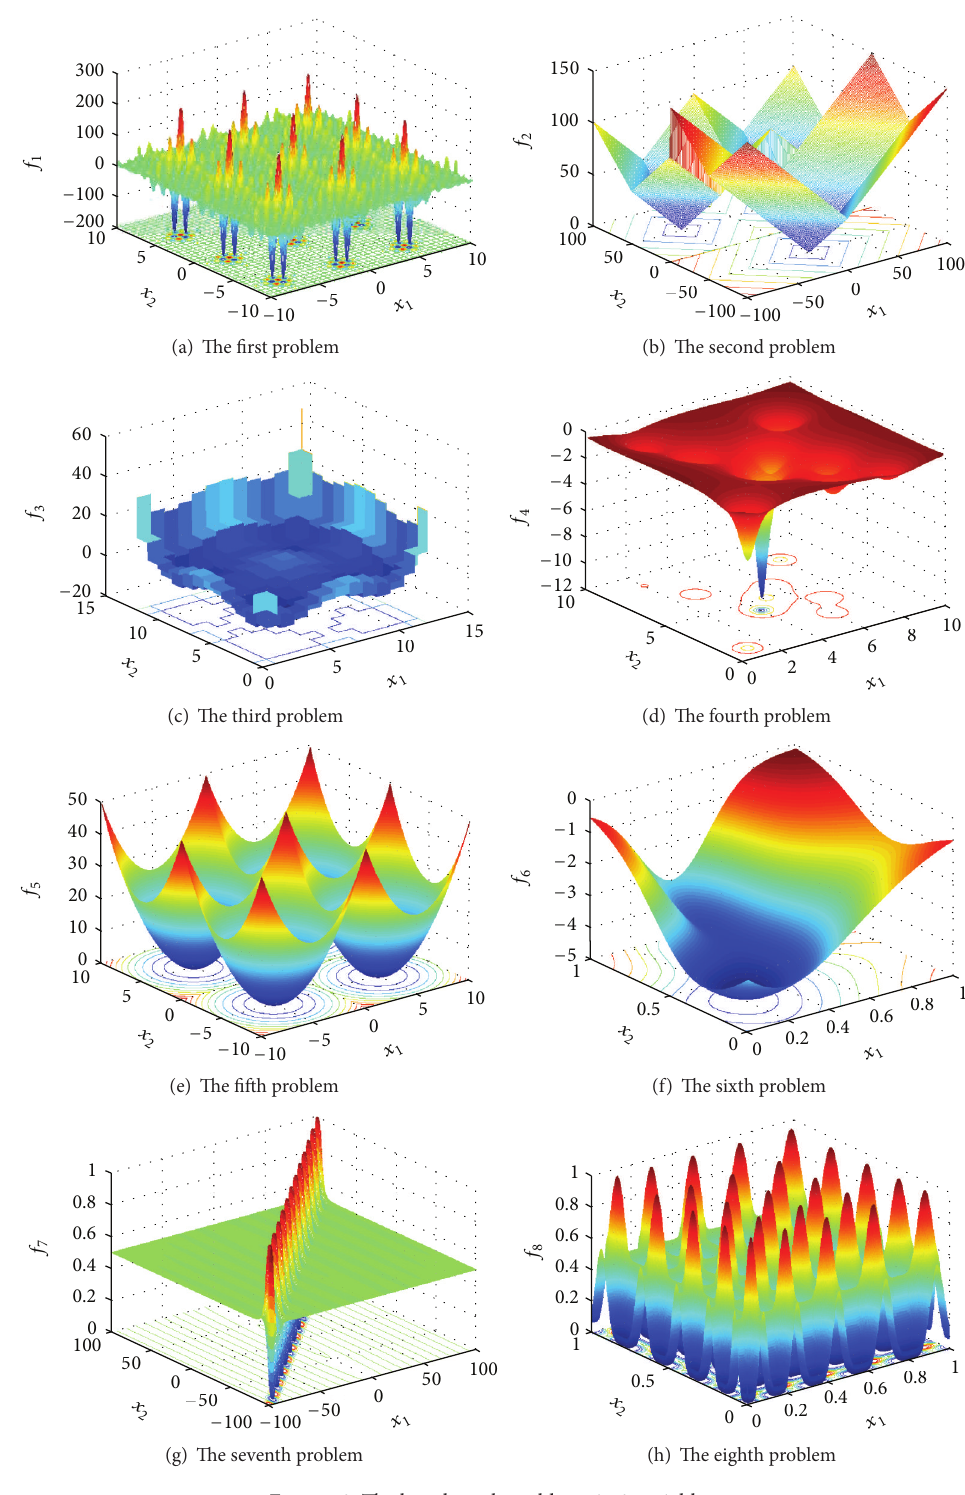
Figure 2: The benchmark problems in 2